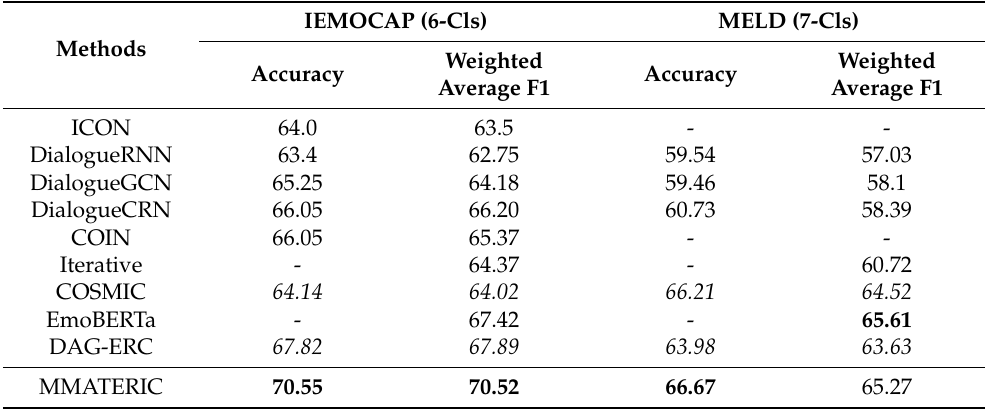
Table 1. Comparison results on MELD and IEMOCAP datasets. Our model results are obtained for a single task combined with weight fusion. The results of the baselines are retrieved from the original papers. The scores in italics are recovered from our experiments using the original